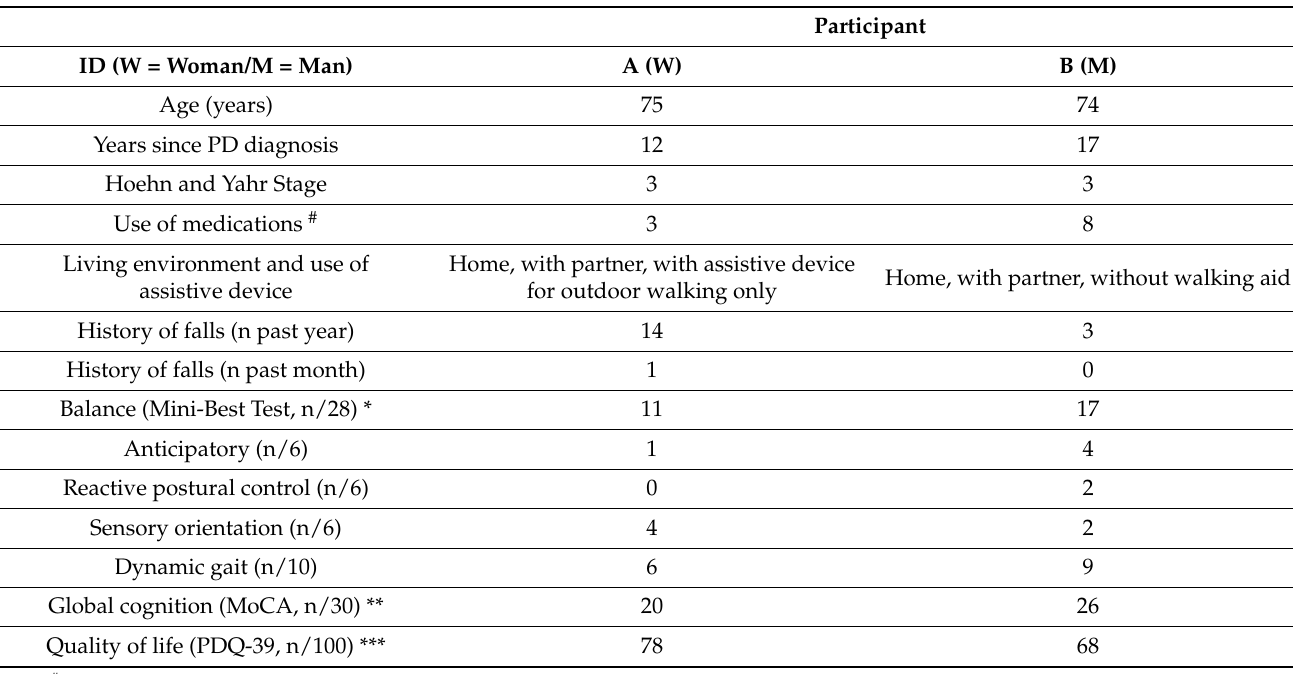
Table 1. Characteristics of the participants at study